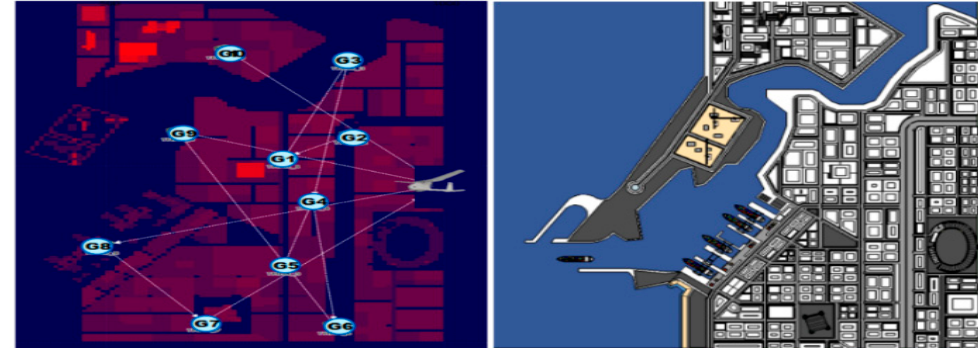
Figure 7. Basic network layout (10 GVNs and 1 URN) in the Riverbed Modeler.